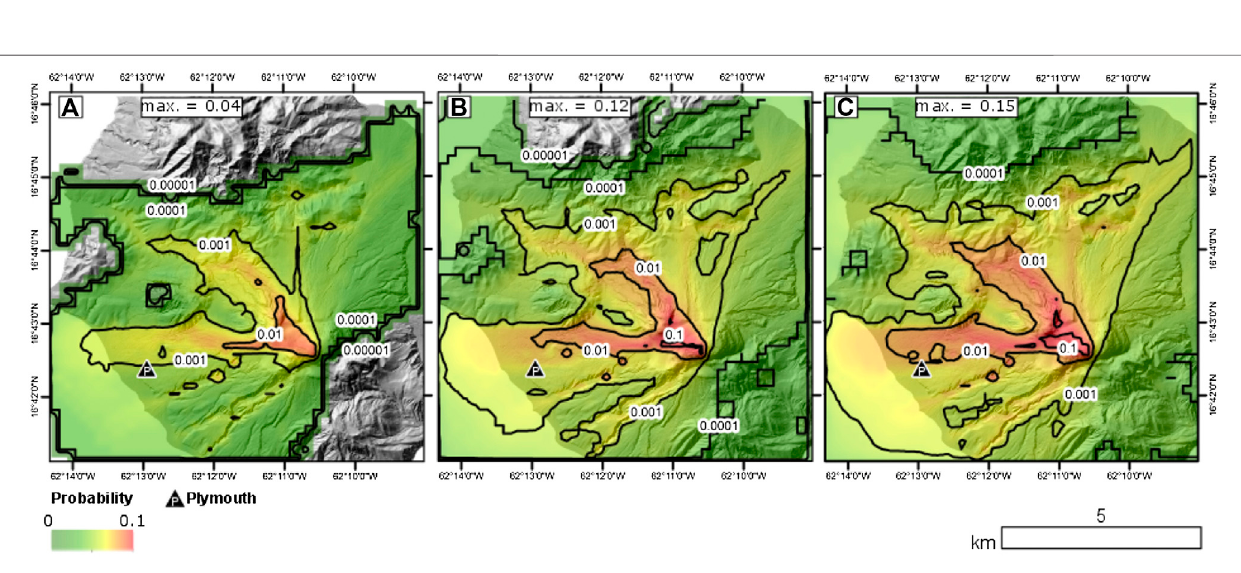
FIGURE 8 | Probability of PDC inundation forecasts plotted on a log 10 color scale, under the assumption of a distribution for p ( ϕ ) that is a point mass at ϕ (cid:2) 135 + , i.e.,northwesttowardtheBelhamValley.Inundationprobabilitycontoursareplottedforvisualreference.Panel (A) isaforecastfor s (cid:2) 1year, (B) for s (cid:2) 5years,and (C) for s (cid:2) 20 years into the